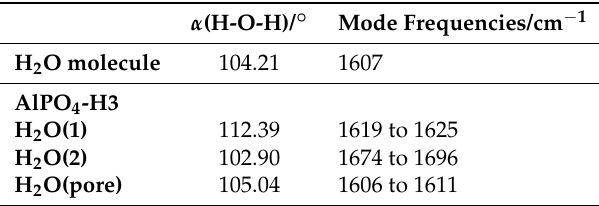
Figure 5. Computed IR ( red curve ) and Raman ( blue curve ) spectra in the frequency range of H-O-H bending vibrations. Table 5. Equilibrium H-O-H angles in AlPO 4 -H3 and frequencies of associated H-O-H bending modes. PBE-TS values of an isolated water molecule are given for